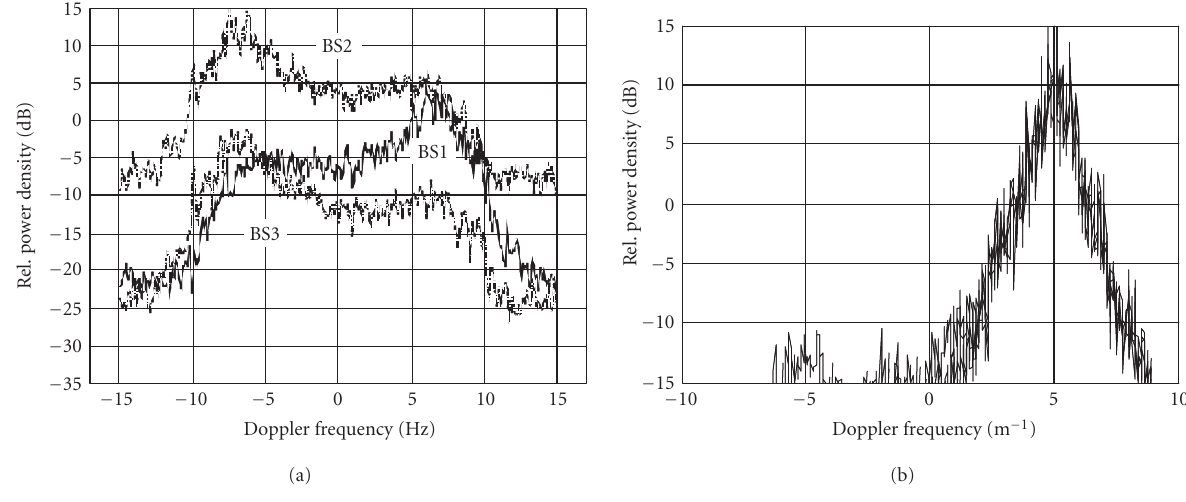
Figure 9: (a) Typical Doppler spectra indoor in the new building: first route, BSs in star, monopole antennas, at the ear (curve BS2 o ff set by +10dB, curve BS3 o ff set by − 5dB). (b) Highly directive main tap (tap 2) outdoor for BS3 in the middle of the short street (Figure 3).